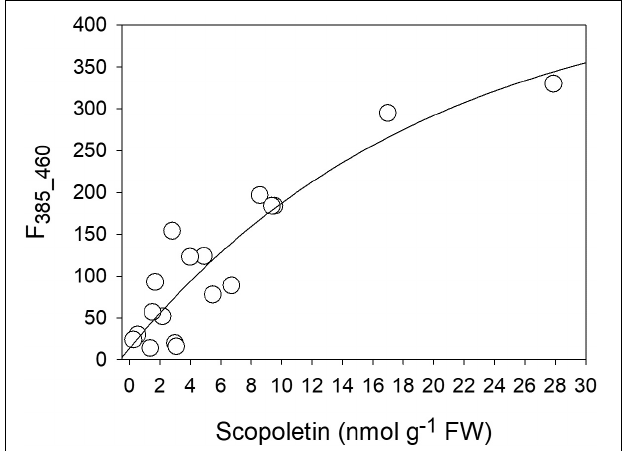
FIGURE 8 | The correlation between the intensity of the 385 nm fluorescence excitation band (F 385_460 ) and the SCT concentration as evaluated by chromatographic